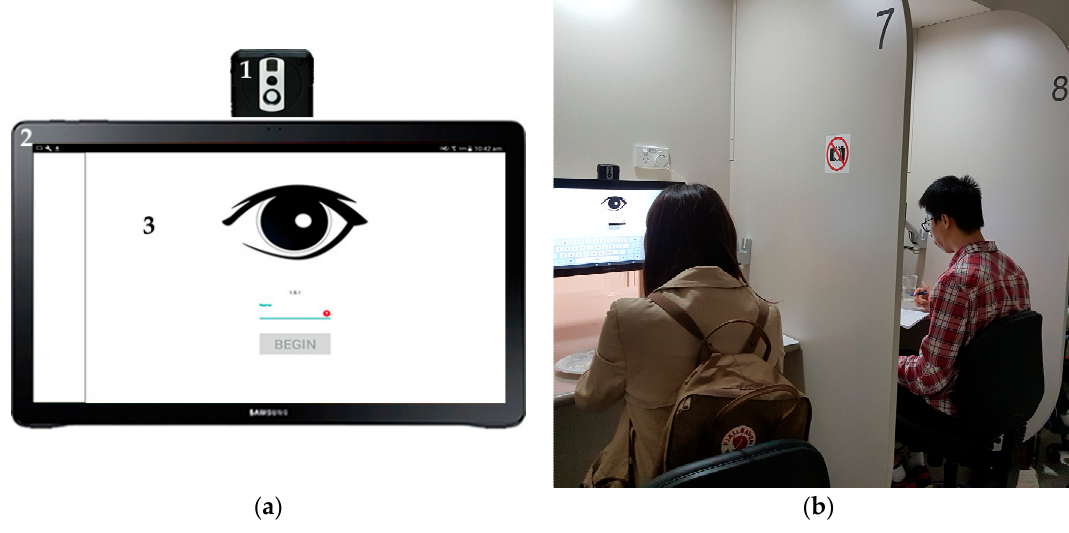
Figure 1. Images of the ( a ) integrated camera system with: (1) the thermal camera FLIR AX8™, and (2) Android tablet displaying the (3) biosensory app start screen; and ( b ) booths in the